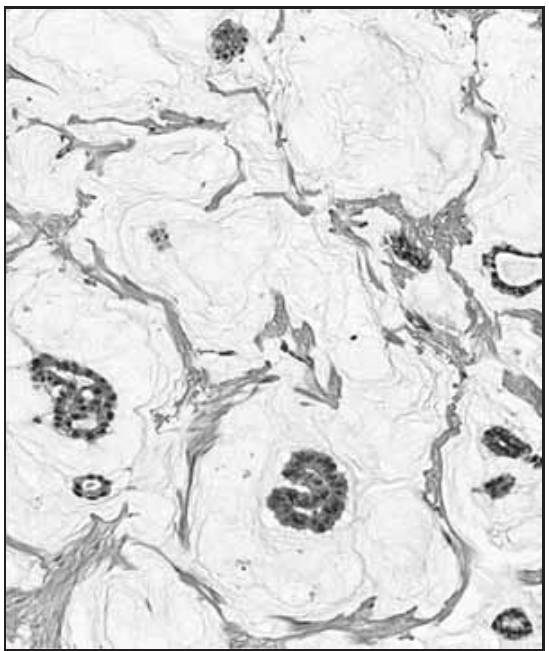
Figura B – Maior detalhe (400×) mostrando células neoplásicas, pequenas e uniformes, exibindo mínimo pleomorfismo